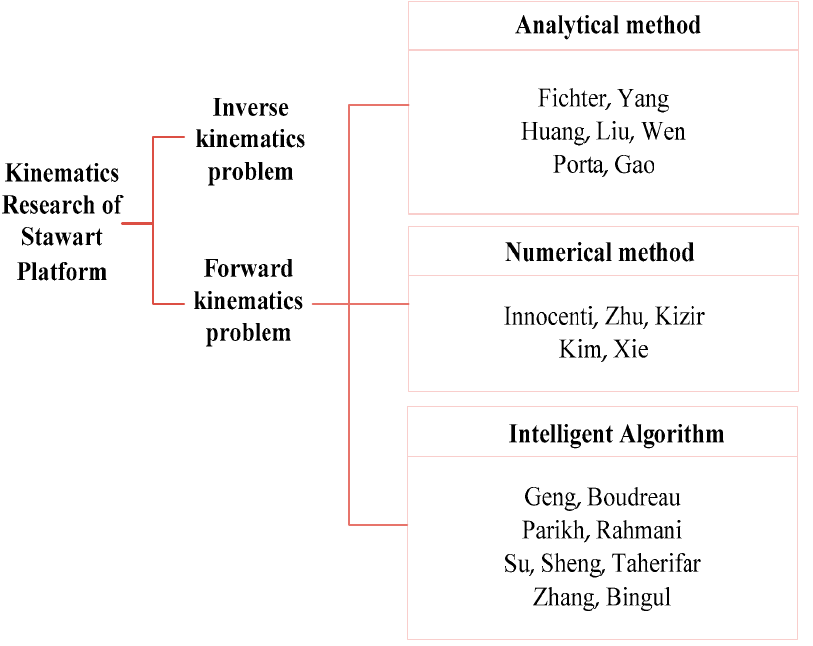
Figure 10. Studies on kinematics of Stewart Platform [50,56–74].